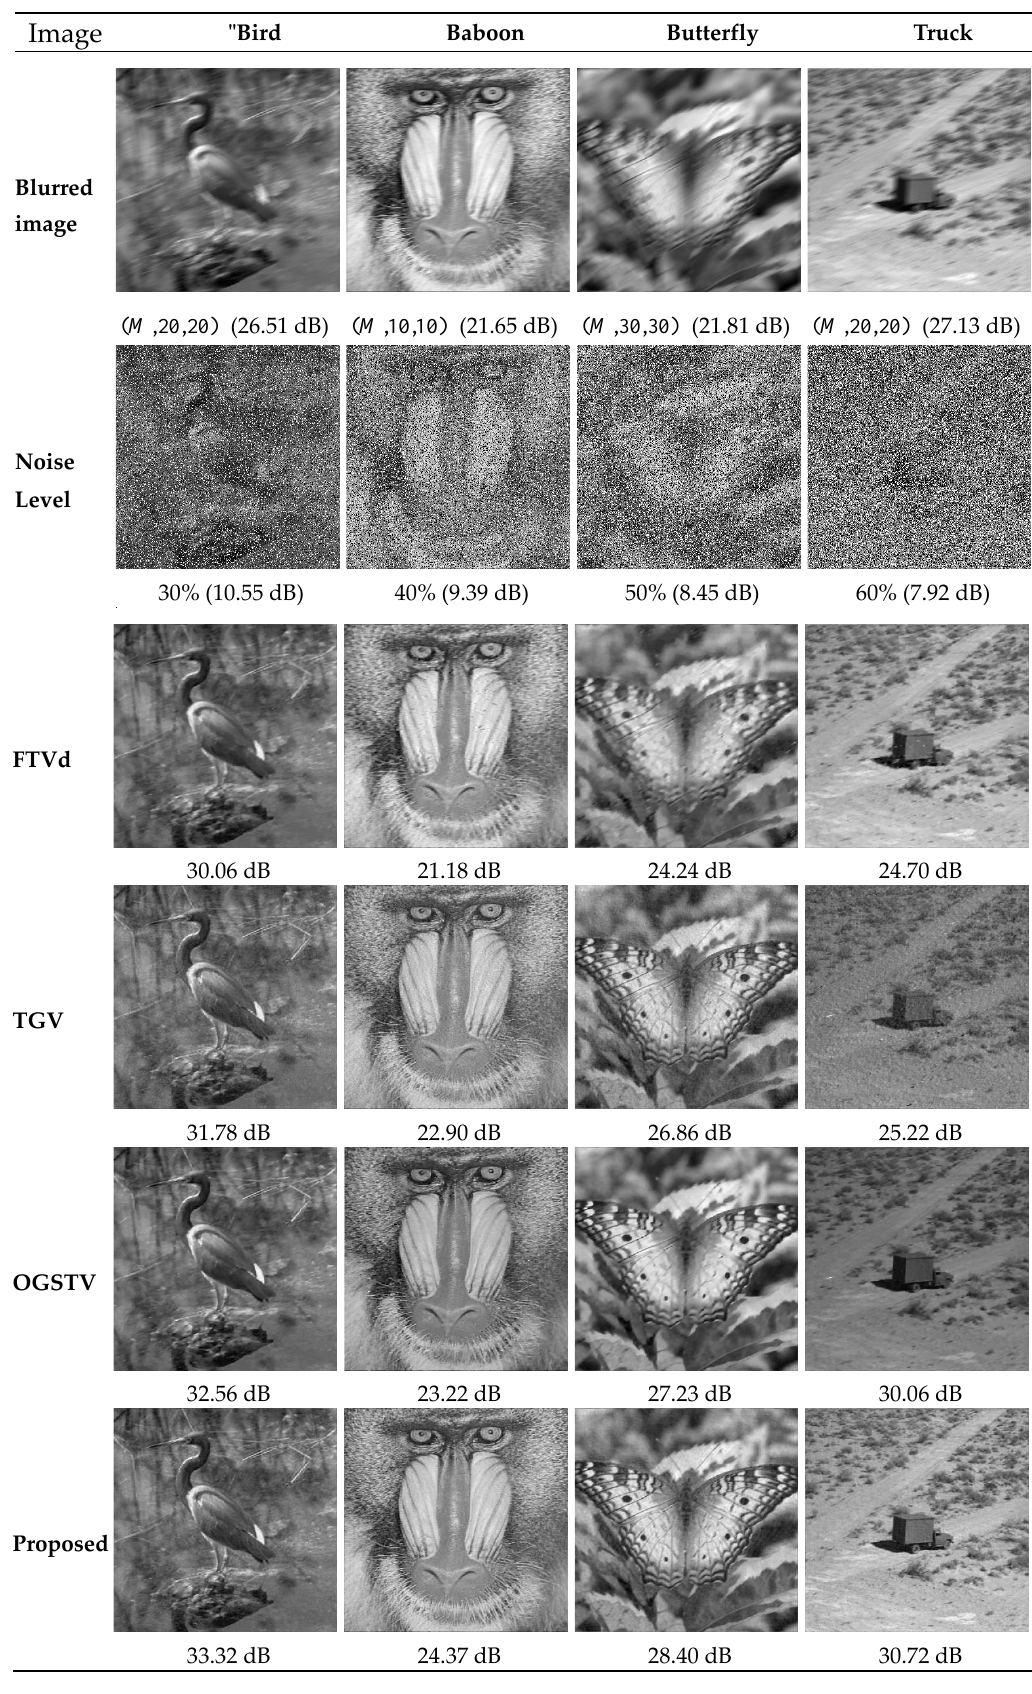
Figure 11. Comparison of the visual effects and PSNRs of restored images for images degraded with different levels of motion blur and impulse noise.